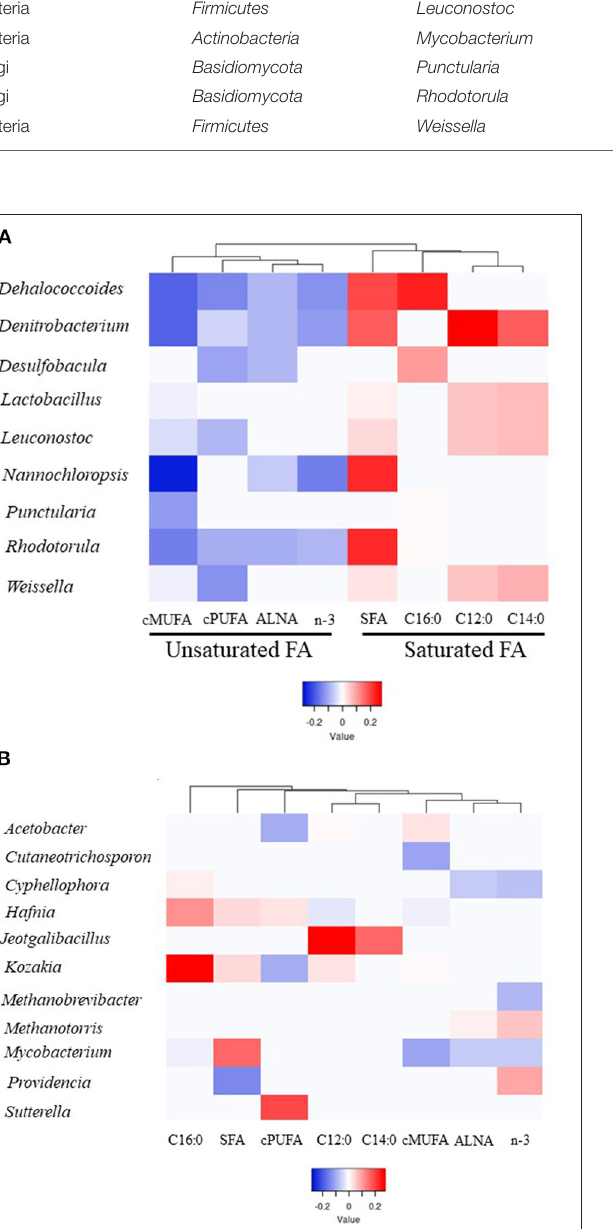
positively correlated with C12:0, C14:0 and total